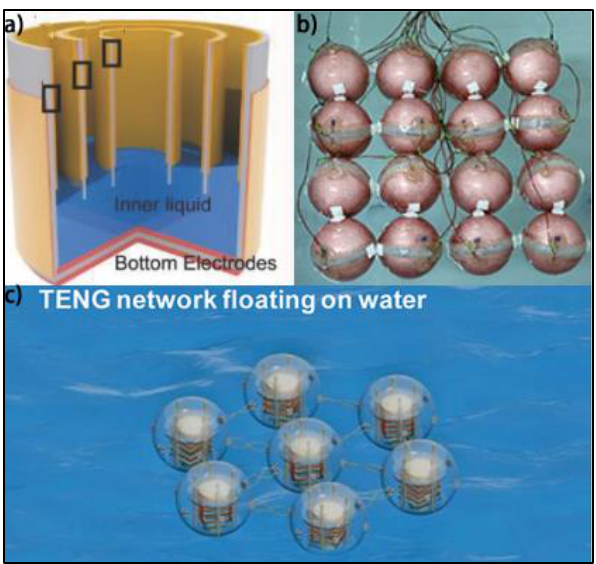
Figure 10. TENG harvester network explored. ( a ) Multi-motion conversion TENG with internal liquid (reproduced with permission [93]. Copyright 2018, Wiley). ( b ) TENG network with flexible connection (reproduced with permission [94]. Copyright 2018, ACS). ( c ) Hexagonal TENG network array (reproduced with permission [95]. Copyright 2019, Wiley).